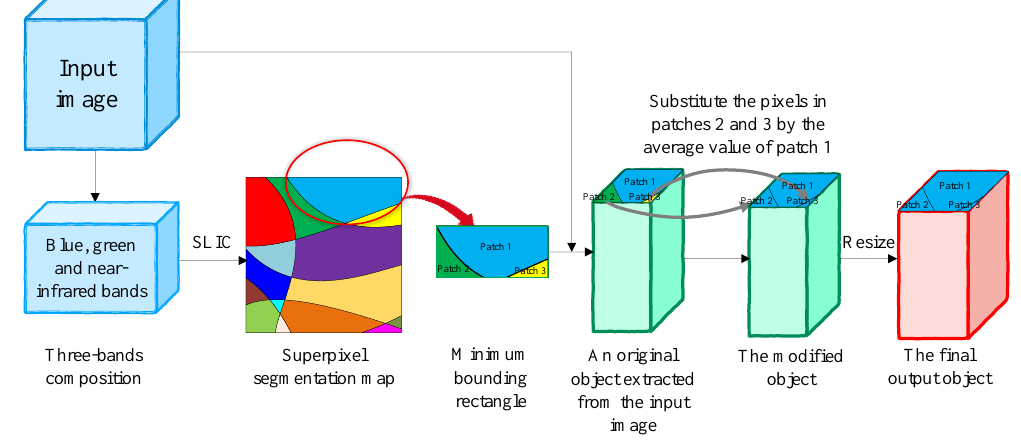
Figure 2. Schematic illustration of constructing the objects.